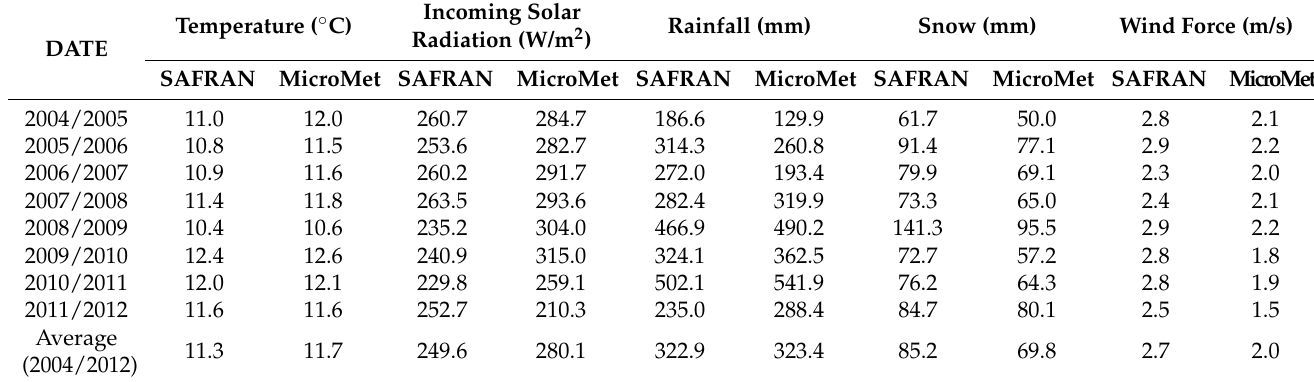
Table 3. Annual average (or cumulative for rainfall and snowfall) of the meteorological variables predicted by SAFRAN and MicroMet over the Rheraya